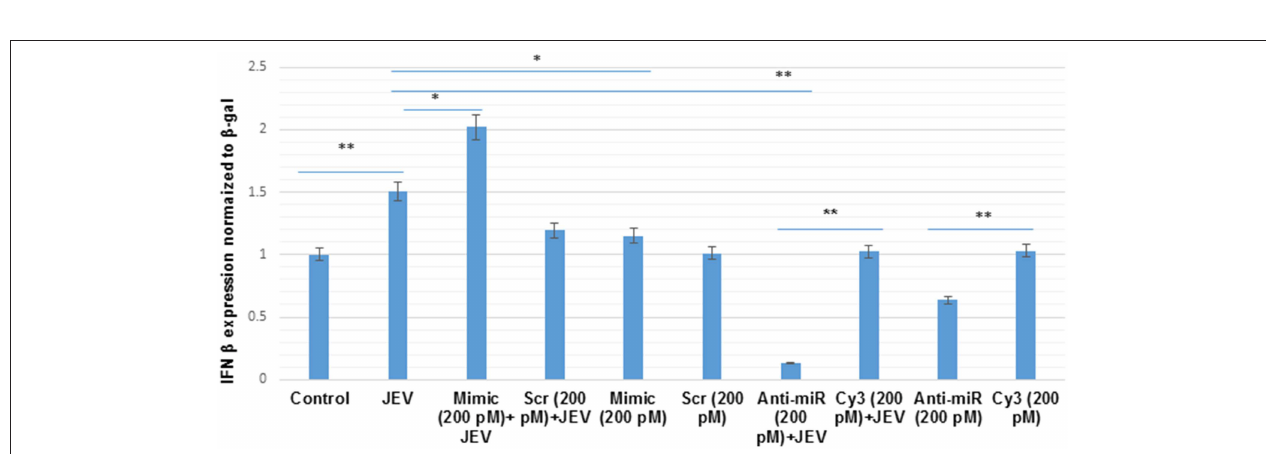
FIGURE 7 | The hsa-miR-374b-5p activates type-I interferon in JEV infected human microglial cells. The graph shows the up-regulation of IFN- β level by 2-fold during microRNA over-expression and JEV infection while the anti-miR during JEV infection suppresses the IFN- β level by 90%. The scramble and cy3 anti-miR has been used as a control to further prove the specificity of microRNA, hsa-miR-374b-5p during JEV infection. In addition, the over-expression alone did increases the IFN- β level by 1.1-fold but it was comparatively lower than both the over-expression and JEV infection. The data are shown as mean ± S.E from three independent experiments ( n = 3 ). The fold change is significant where * denotes P < 0.05, ** denotes P < 0.01, *** denotes P <